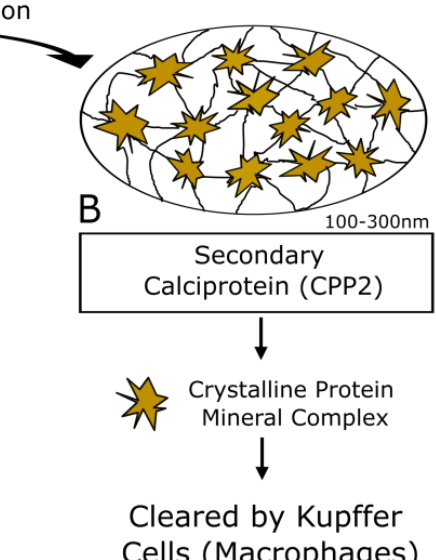
Figure 2. Calciprotein particle formation, maturation and clearance from circulation. ( A ) Primary calciprotein particles (CPP1) are circulating particles formed of a combination of CaP mineral and several mineral regulatory proteins including Fetuin-A, MGP and GRP, where the mineral is held in an amorphous shape. CPP1 are cleared by highly specialized liver sinusoidal endothelial cells. ( B ) Under conditions of hyperphosphatemia and hypercalcemia, as observed in mineral and bone disorder in CKD, CPP1 undergo an amorphous to crystalline transition into needle-shaped crystallike secondary CPPs (CPP2). CPP2 are described to be cleared by resident liver macrophages (Kupffer